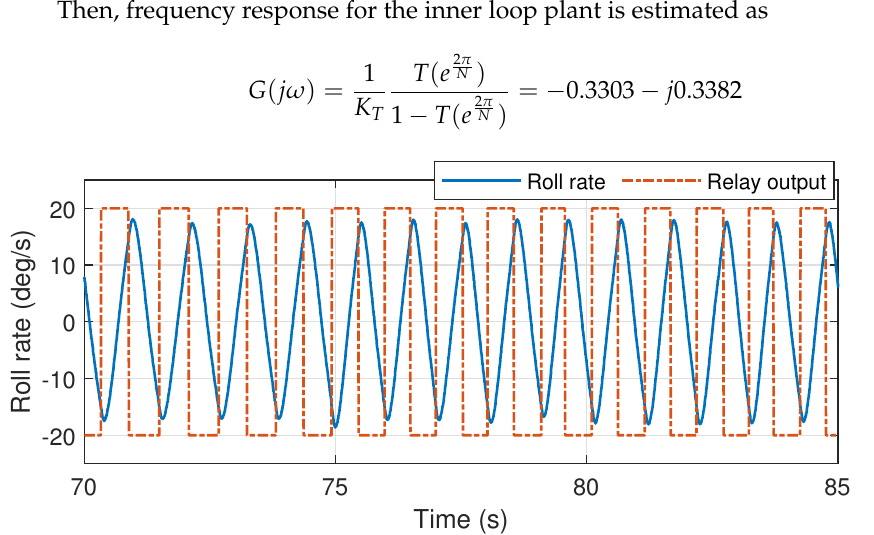
Figure 9. Inner loop relay feedback experiment for roll